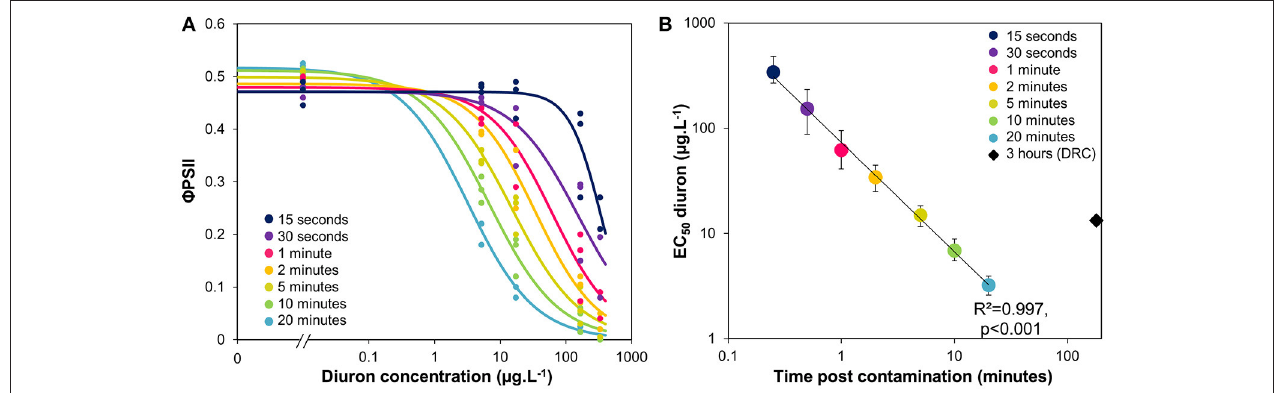
FIGURE 3 | (A) Experimental ϕ PSII inhibition curves with increasing diuron concentrations, after different durations of exposure. (B) Variation of EC 50 values ( ± CI, 95%) with duration of exposure, given by the models fitted in Figure 3A . The black diamond shows the EC 50 previously obtained with a 3-h exposure for comparison (dose-response curve–DRC–presented in SI1).